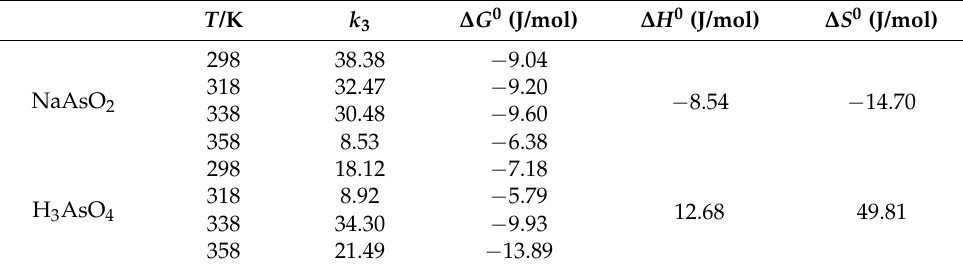
Table 6. Adsorption thermodynamic parameter of